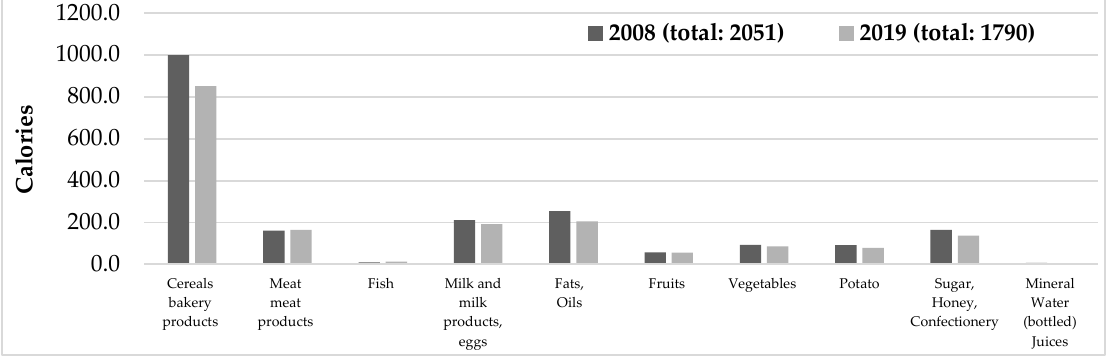
Figure 2. Average daily per capita calories (kcal/day). Armenia. 2008 and 2019.